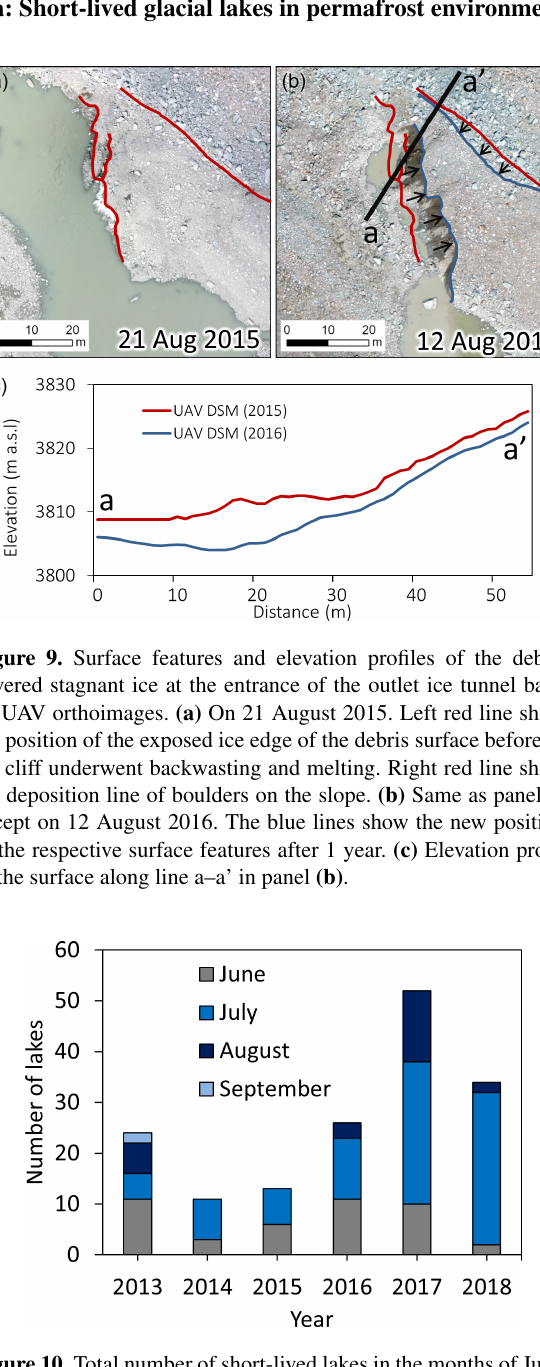
Figure 10. Total number of short-lived lakes in the months of June– September during 2013–2018 in the northern part of the Teskey Range derived by Landsat 7/8, Sentinel-2, and PlanetScope satel- lite